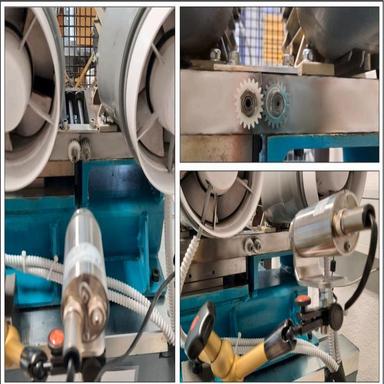
Small experimental testbench for durability testing of polymer gears.